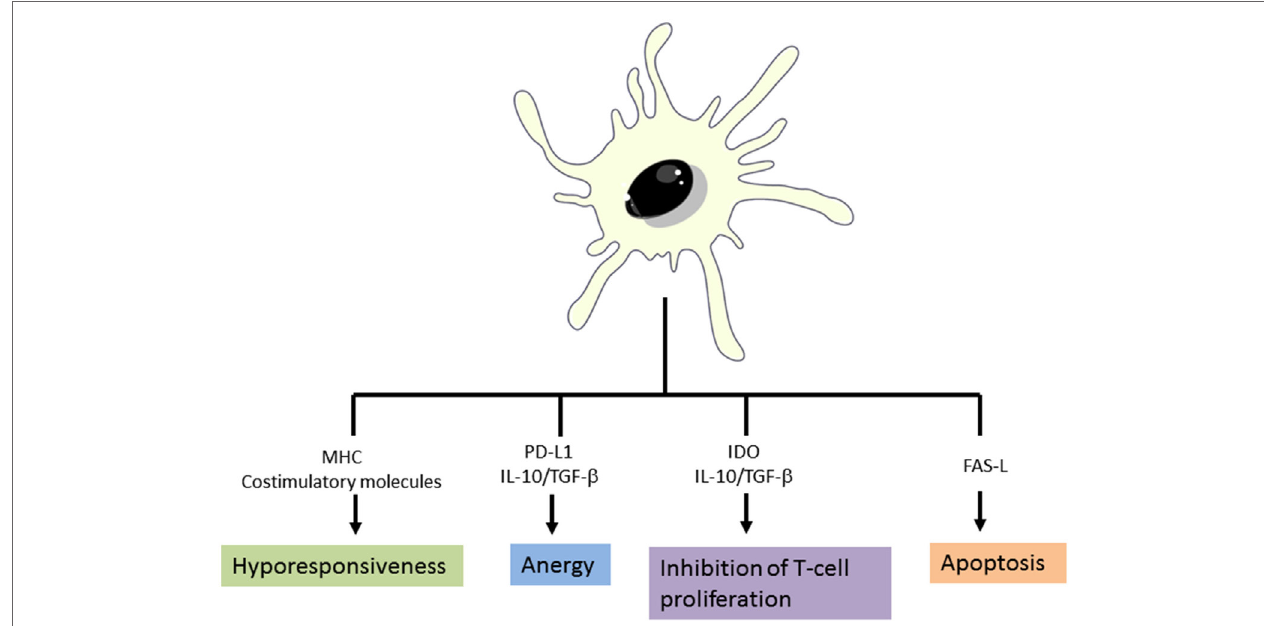
FigURe 4 | Mechanisms of tolerance induction by dendritic cells. Adapted from: Cabezón et al.